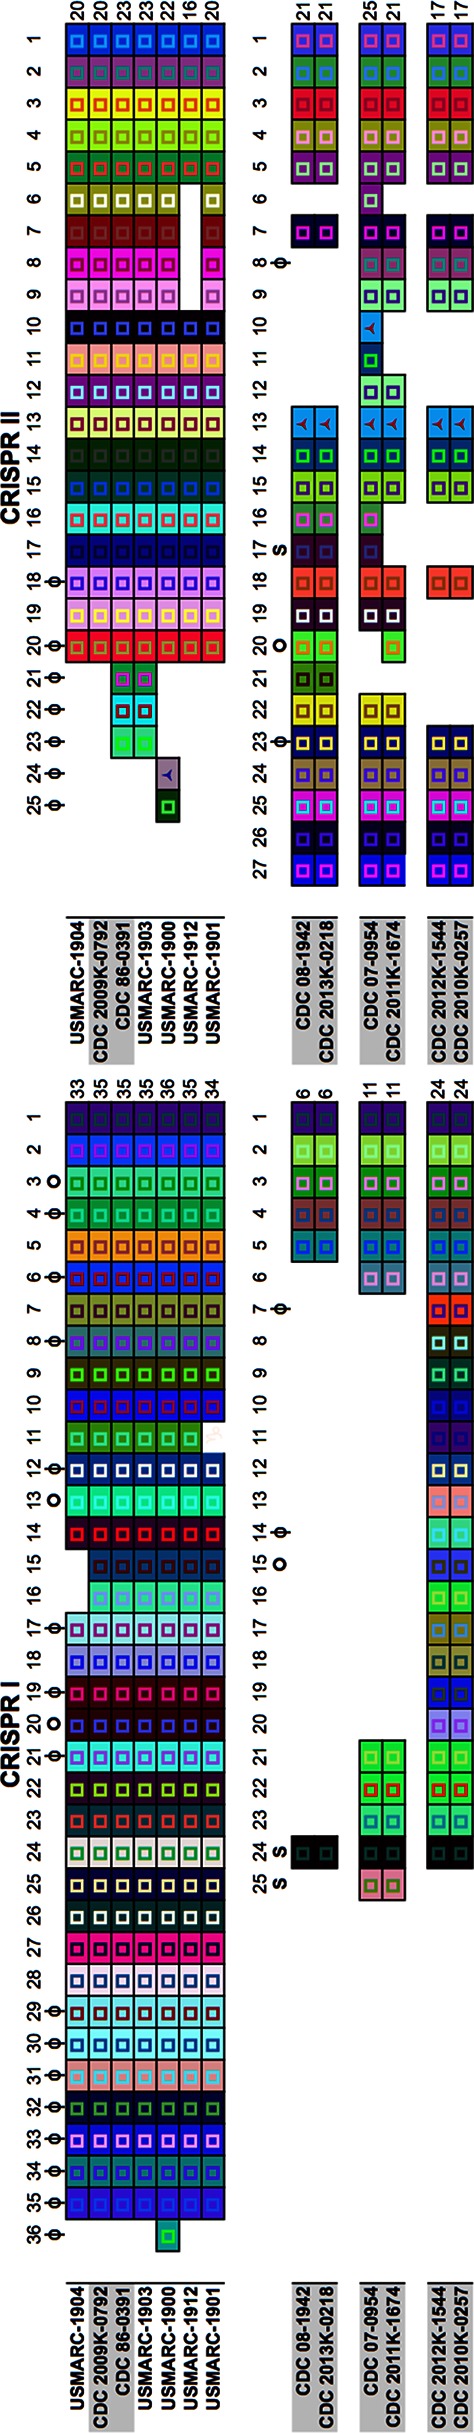
Montevideo CRISPR spacer arrays. Extended CRISPR spacer arrays in clade I and matches of these arrays to prophages suggests a more active CRISPR. The 'Φ' above the spacers indicates top hits against bacteriophages and/or plasmids while the 'ο' indicates hits against plasmids only. 'S' indicates self-hits and spacer tally is indicated on the right. Spacer sequences are converted into two colour symbols through the CRISPR DB II Macro. Spacers of the same colour and symbols indicate sequence homology.